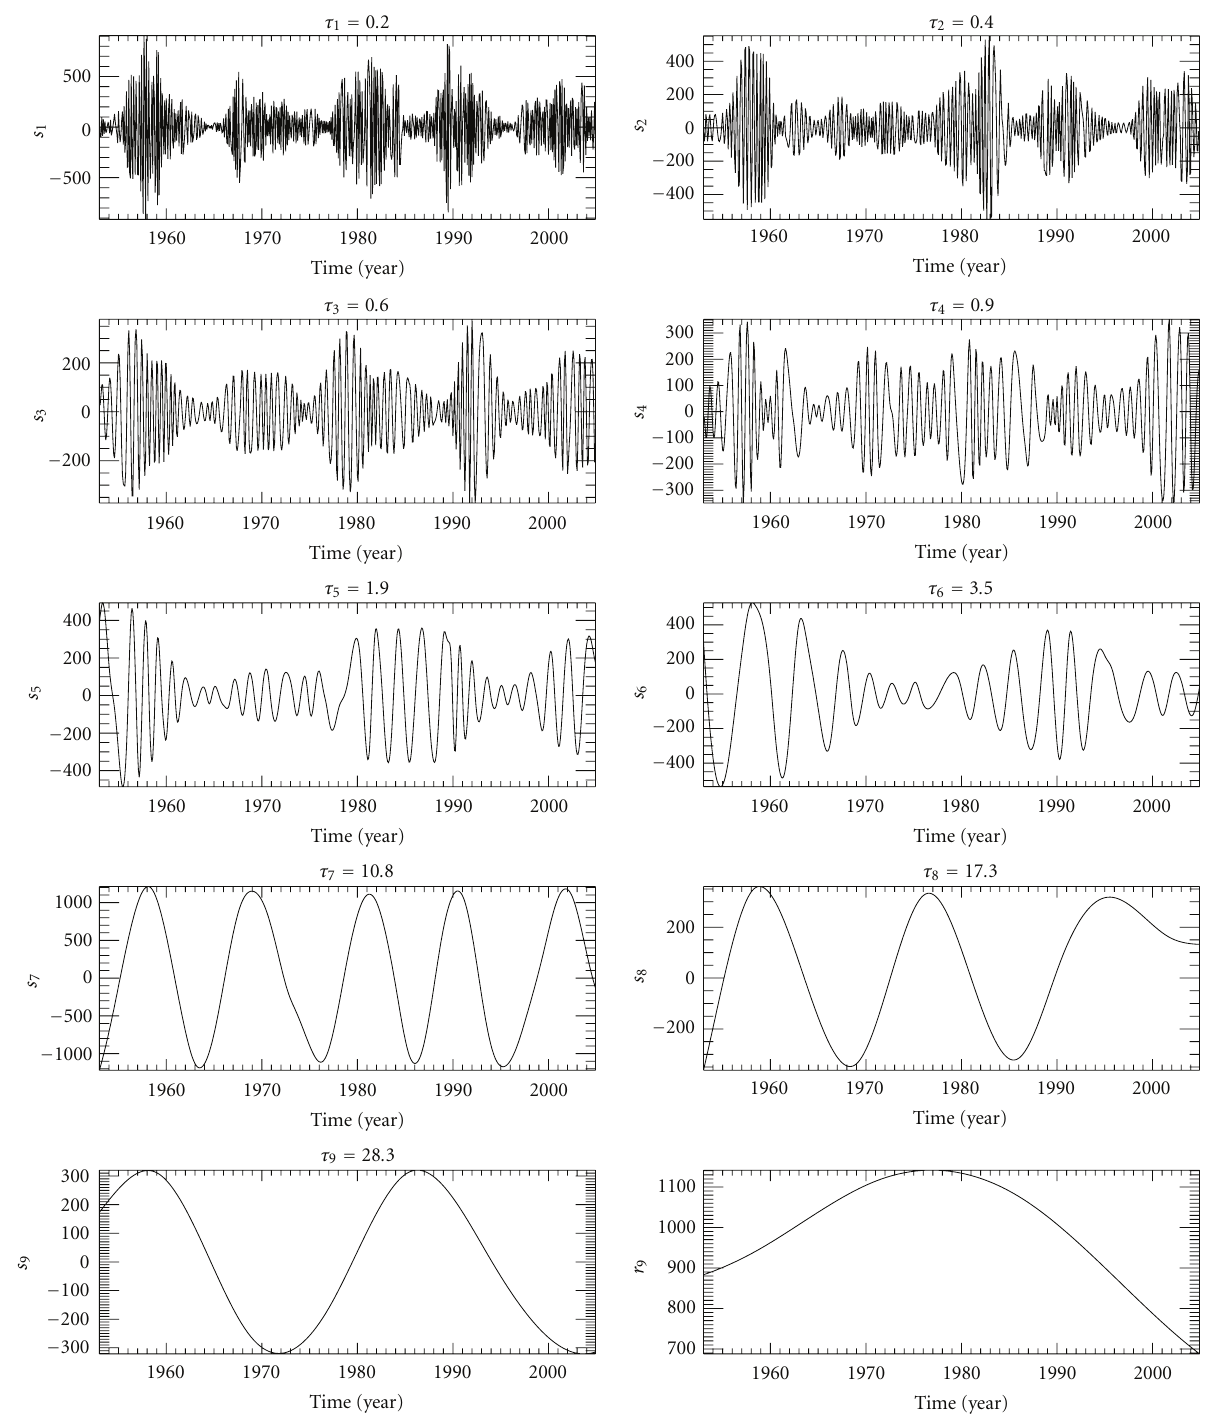
Figure 4: IMFs ( j values from 1 to 9) obtained by performing the EMD on SA data, along with their characteristic periods τ j in years.